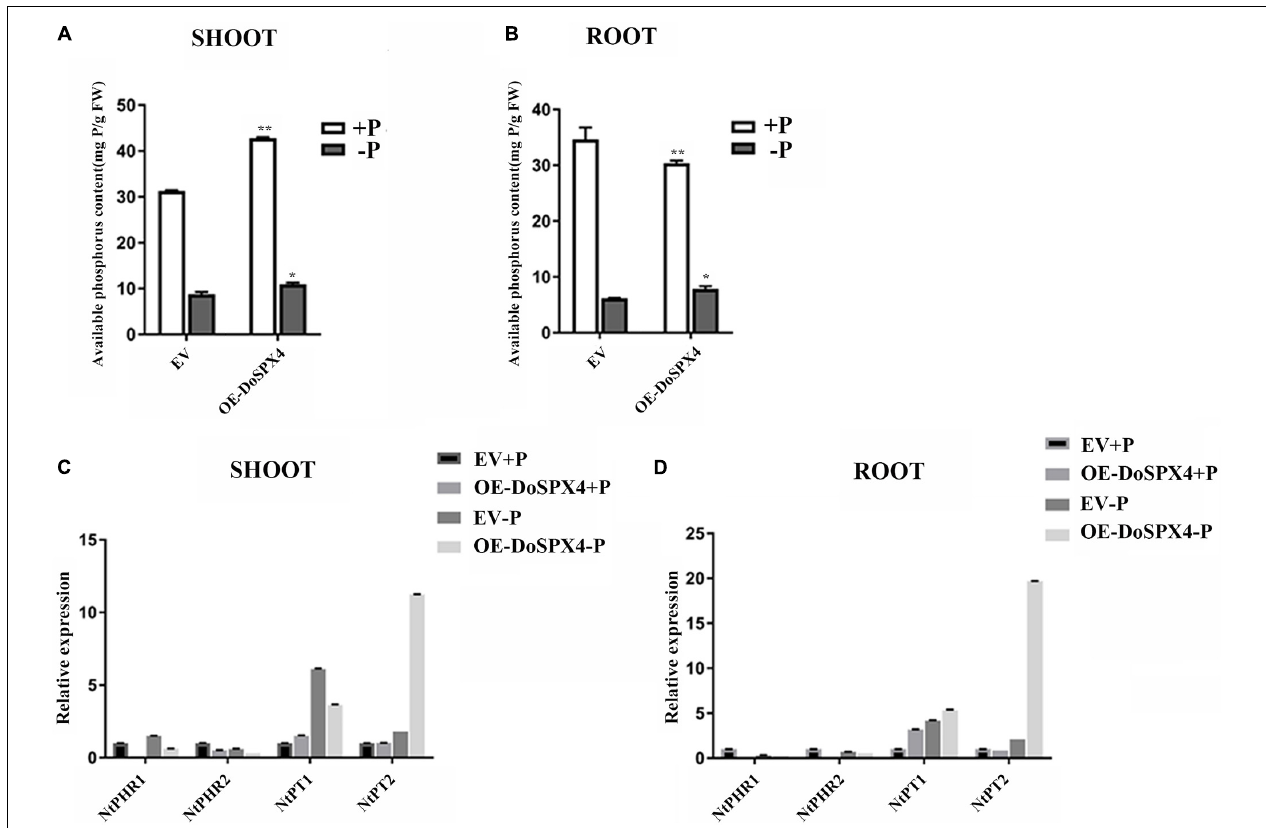
FIGURE 8 | Determination of indices in transgenic N. tabacum . (A) The available Pi concentration in shoot in OE- DoSPX4 N. tabacum . (B) The available Pi concentration in root in OE- DoSPX4 N. tabacum . (C) The expression analysis of NtPHR1/2 and NtPT1/2 in shoot in OE- DoSPX4 N. tabacum . (D) The expression analysis of NtPHR1/2 and NtPT1/2 in root in OE- DoSPX4 N. tabacum . Each sample included at least three replicates, and the values are the means ± SDs. *Indicates that the difference is significant, **Indicates that the difference is very significant.